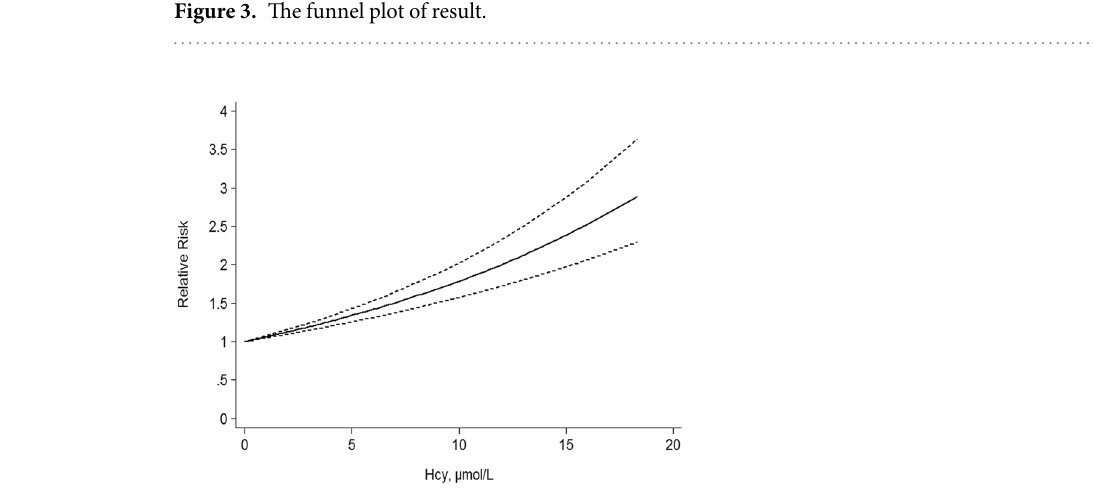
Figure 4. Dose-response relationships between Hcy levels and all-cause mortality